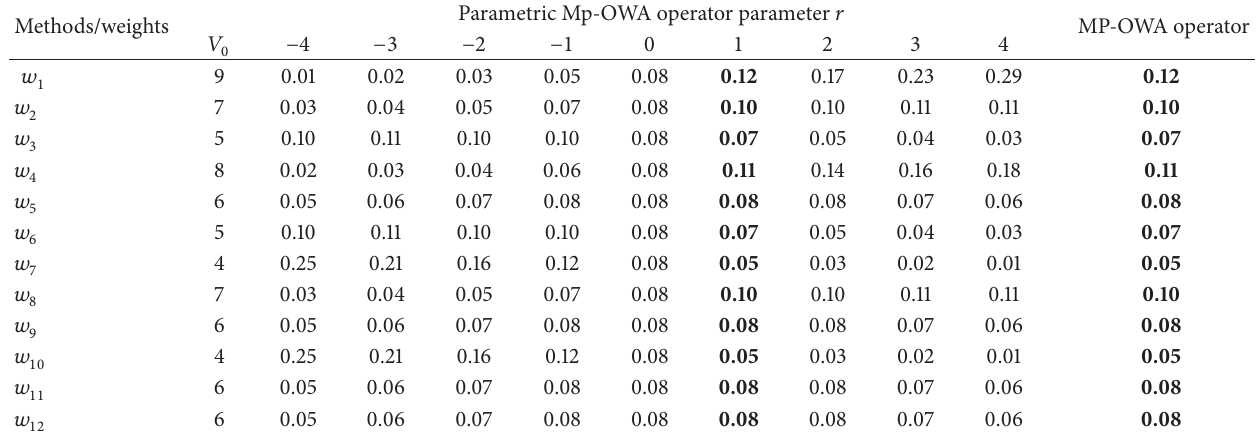
Table 5: Weights given to search engines with different values of parameter 𝑟 .